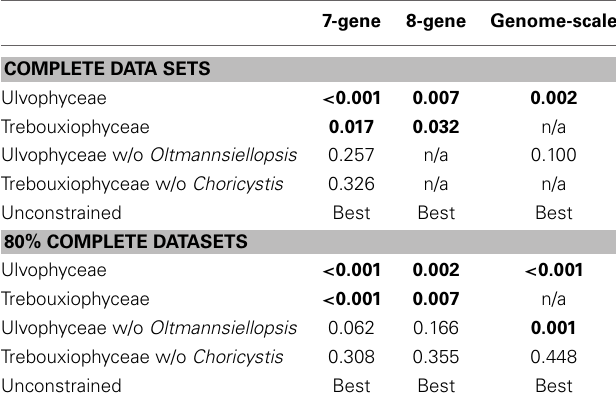
Table 2 | Results of the AU test investigating the monophyly of Ulvophyceae, Trebouxiophyceae, and the two classes with the exclusion of Oltmannsiellopsis and Choricystis ,